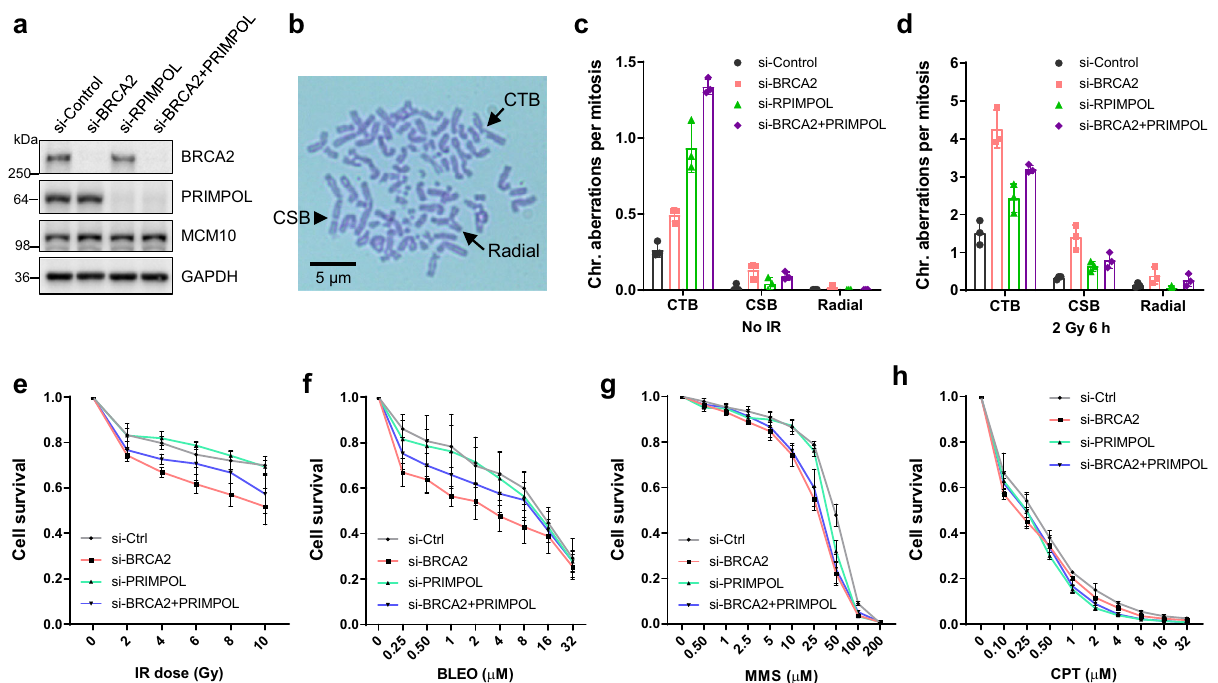
Fig. 3 Impact of PRIMPOL loss on genome stability and cell viability after DNA damage in BRCA2-pro fi cient and -de fi cient cells. a Western blots showing levels of siRNA-mediated depletion of BRCA2, PRIMPOL, or BRCA2 + PRIMPOL in U2OS cells. Similar results were obtained in n = 3 independent experiments. b A representative image of a mitotic spread after Giemsa staining showing different forms of abnormal chromosomes. CTB, chromatid break; CSB, chromosomal break; Radial, radial chromosome. c , d Quanti fi cation of chromosomal aberrations in U2OS cells treated with control, BRCA2, PRIMPOL, or BRCA2 + PRIMPOL siRNAs without IR ( c ) or 6 h after 2 Gy of IR ( d ). Data are presented as mean ± s.d. from n = 3 independent experiments. e – h Sensitivity of the above siRNA-treated cells to IR ( e ), BLEO ( f ), MMS ( g ), and CPT ( h ). Cell viability was determined 72 h after treatment. Results are presented as mean ± s.d. from n = 3 independent experiments, each conducted in technical triplicates. Source data are provided as a Source Data fi